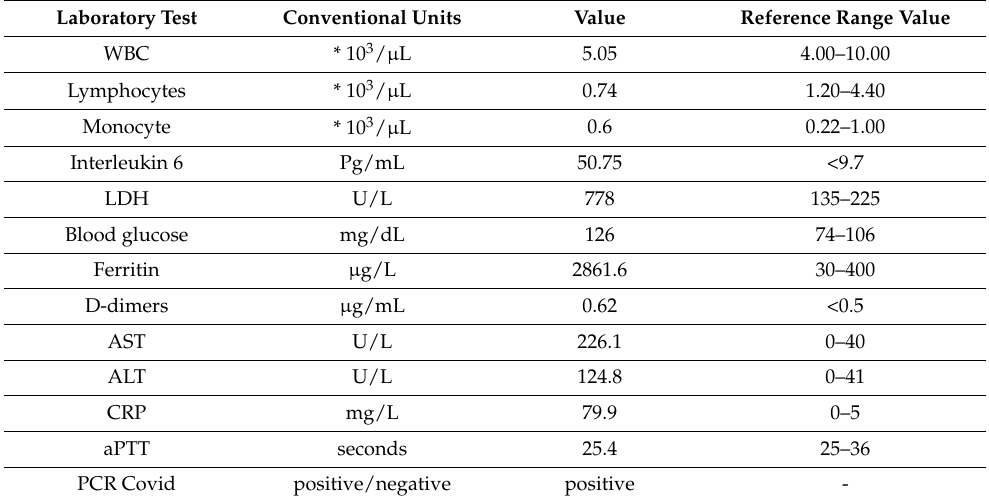
Table 1. Complete blood